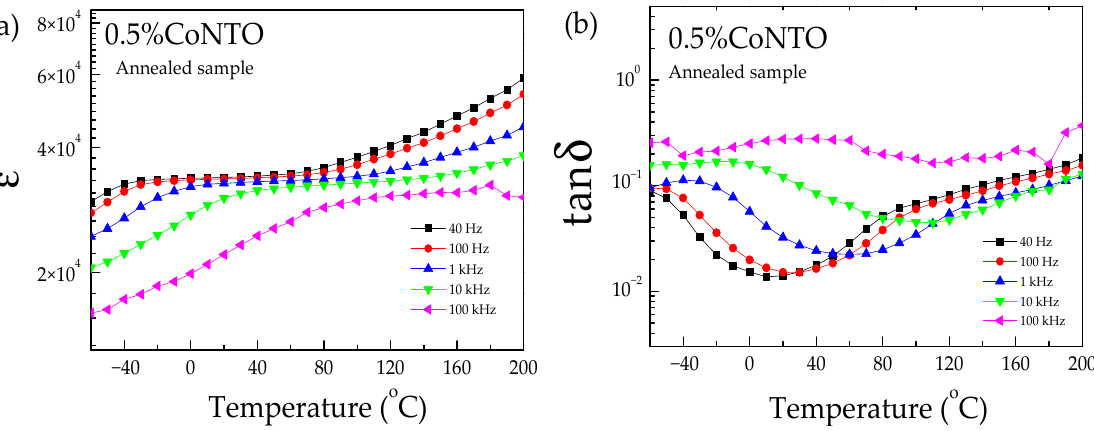
similar to that observed in ACu 3 Ti 4 O 12 ceramics. This result may be due to the Maxwell– Wagner polarization relaxation at the insulating GBs [40,41]. The relaxation peak of tan δ shifts to high temperatures as the frequency increases, indicating a thermally activated relaxation mechanism.